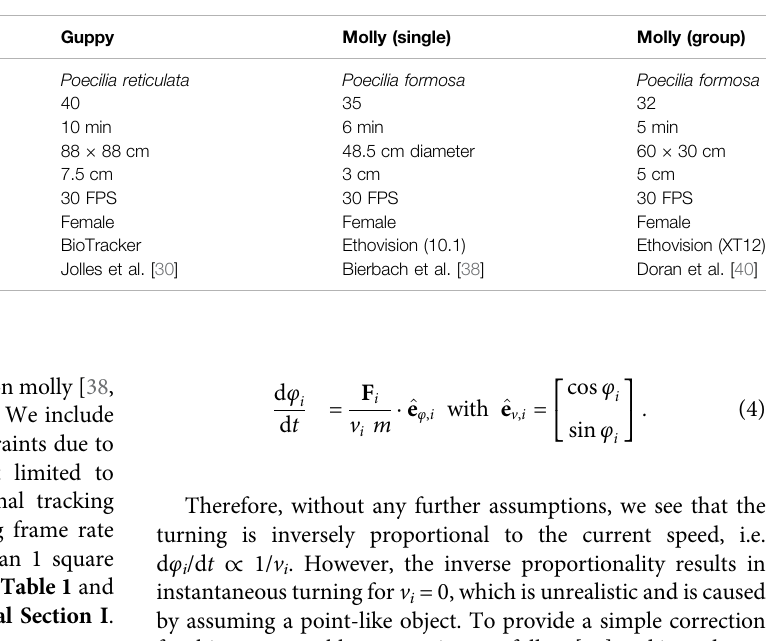
TABLE 1 | List of previously published tracking data used in our analysis. The table lists major characteristics of the datasets we used to show within-individual speed variability. The # of tracks indicates the number of individual tracks used for the analysis. Du to the initial study designs and questions, tracks may represent repeated measures of the same (Guppy: 20 individuals, RoboFish 1 replica) or different individuals (Molly single ind, Molly groups: 8 with 4 ind. per group). Please fi nd exact study designs in the respective